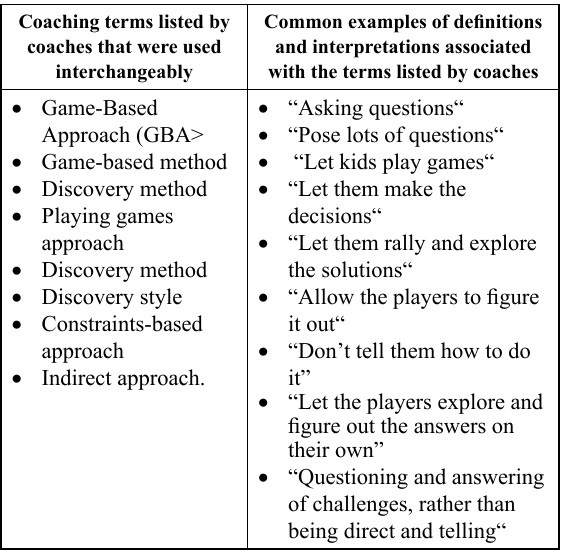
Table 2. Outline of the terms that the interviewed coaches ( n = 13)